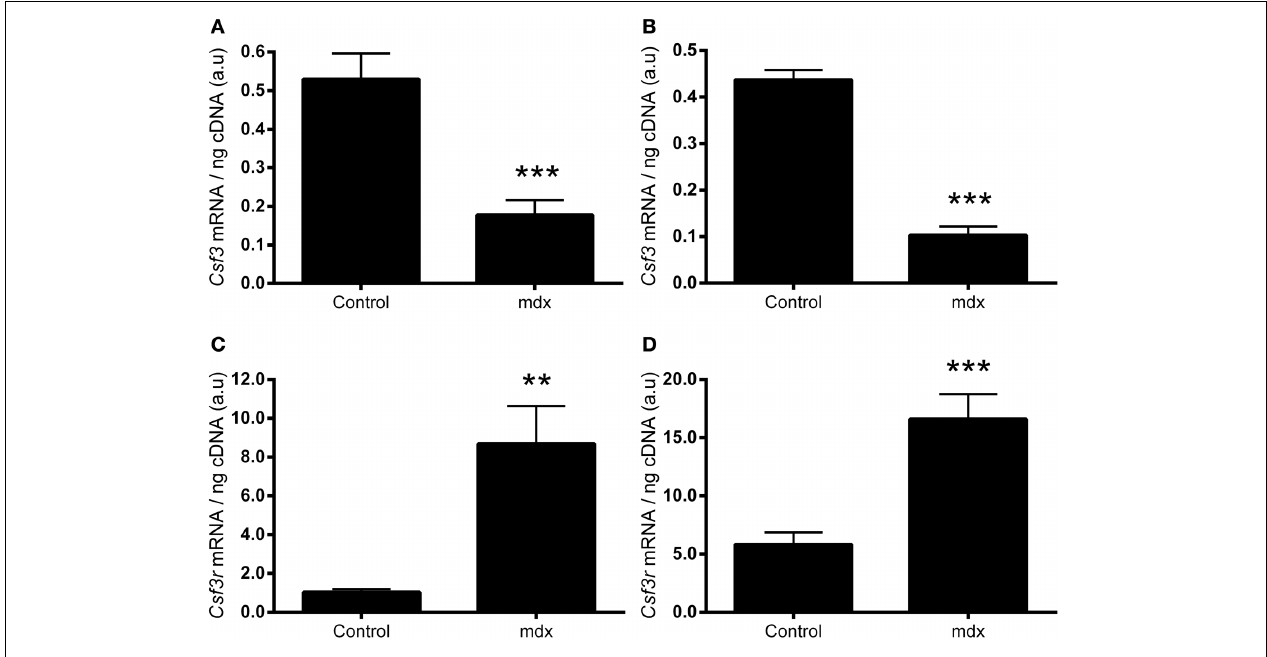
FIGURE 3 | mRNA expressions of G-CSF and G-CSFR mRNA in muscles from mdx mice. (A) G-CSF ( Csf3 ) mRNA in the tibialis anterior (TA) muscle. (B) G-CSF ( Csf3) mRNA in the diaphragm. (C) G-CSFR